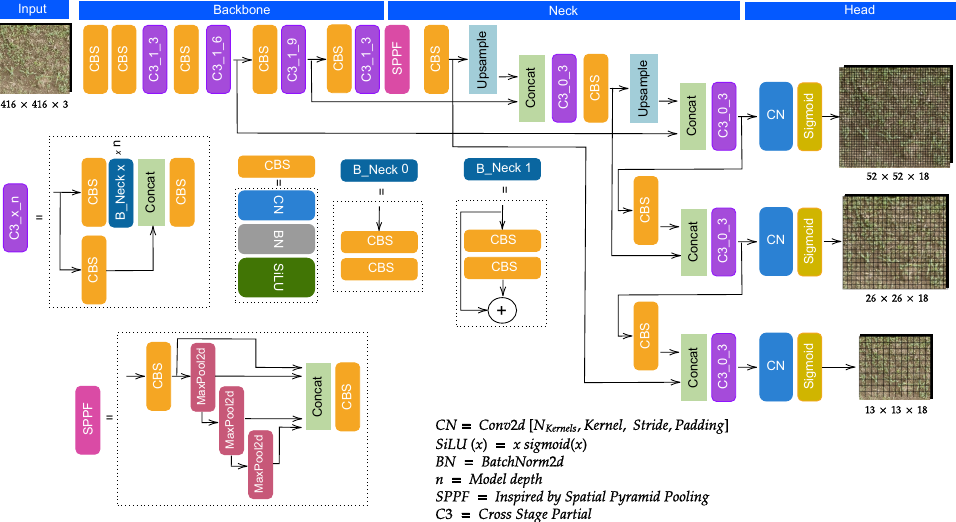
Figure 7. Diagram of the YOLOv5-l (V6.0/6.1) architecture with an input image of 416 × 416 pixels and 3